Question: Write a single sentence explaining what this figure depicts.
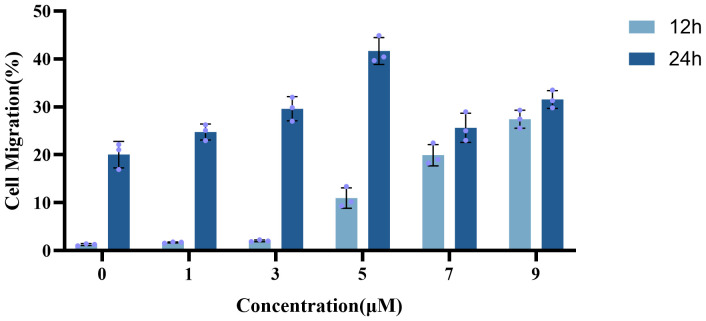
Answer: Quantitative analysis of PSMδ-induced HDPC migration. Migration rates of HDPCs at 12 h and 24 h after treatment with different concentrations of PSMδ (0–9 μM). Data are mean ± s.d. (n = 3). Statistical significance was determined by two-tailed Mann-Whitney U test. At 12 h, significant promotion of migration was observed at 5, 7, and 9 μM compared with control (all P < 0.01), with the highest rate at 9 μM (P < 0.05 vs. other concentrations). At 24 h, migration rates at 1 and 3 μM were significantly elevated relative to control ( P < 0.05); the peak effect was achieved at 5 μM ( P < 0.01), and 7 and 9 μM still showed significant pro-migratory effects compared with control ( P < 0.05) but were significantly lower than at 5 μM ( P < 0.01).